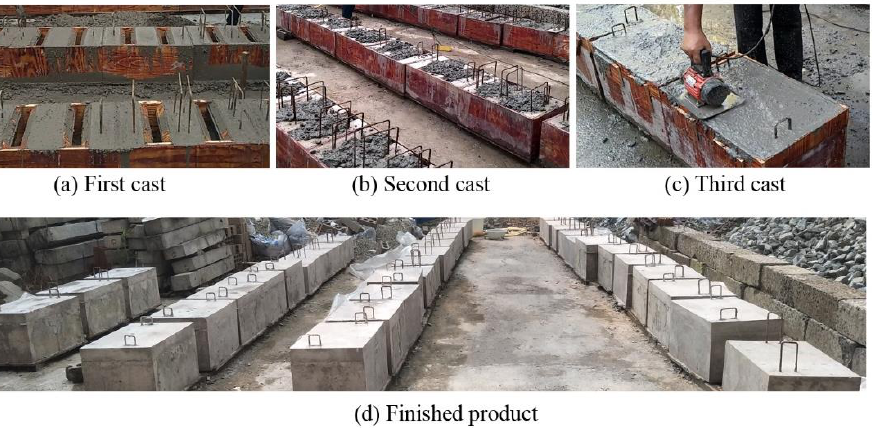
Figure 2. Specimen construction procedure. Table 1. Mix design for C30.